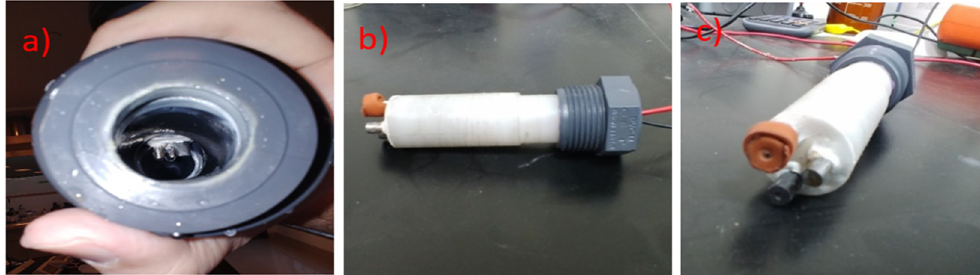
Figure 6. ( a ) Projection of sensor electrodes into the flow ( b ) isometric view of the sensor ( c ) side view. The orange rubber cap keeps the reference sensor (Ag/AgCl) from drying out.